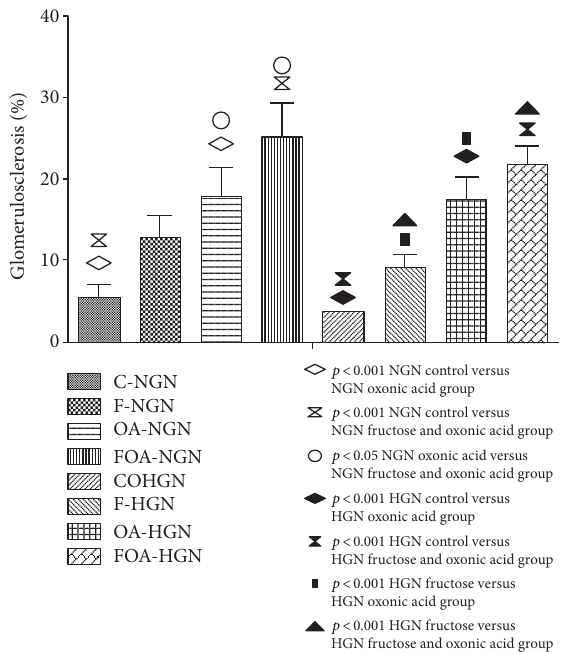
Figure 3: Percentage of renal glomerulosclerosis. NGN (normogonadic); HGN (hypogonadic); CO (control); F (fructose); OA (oxonic acid); FOA (fructose and oxonic acid).